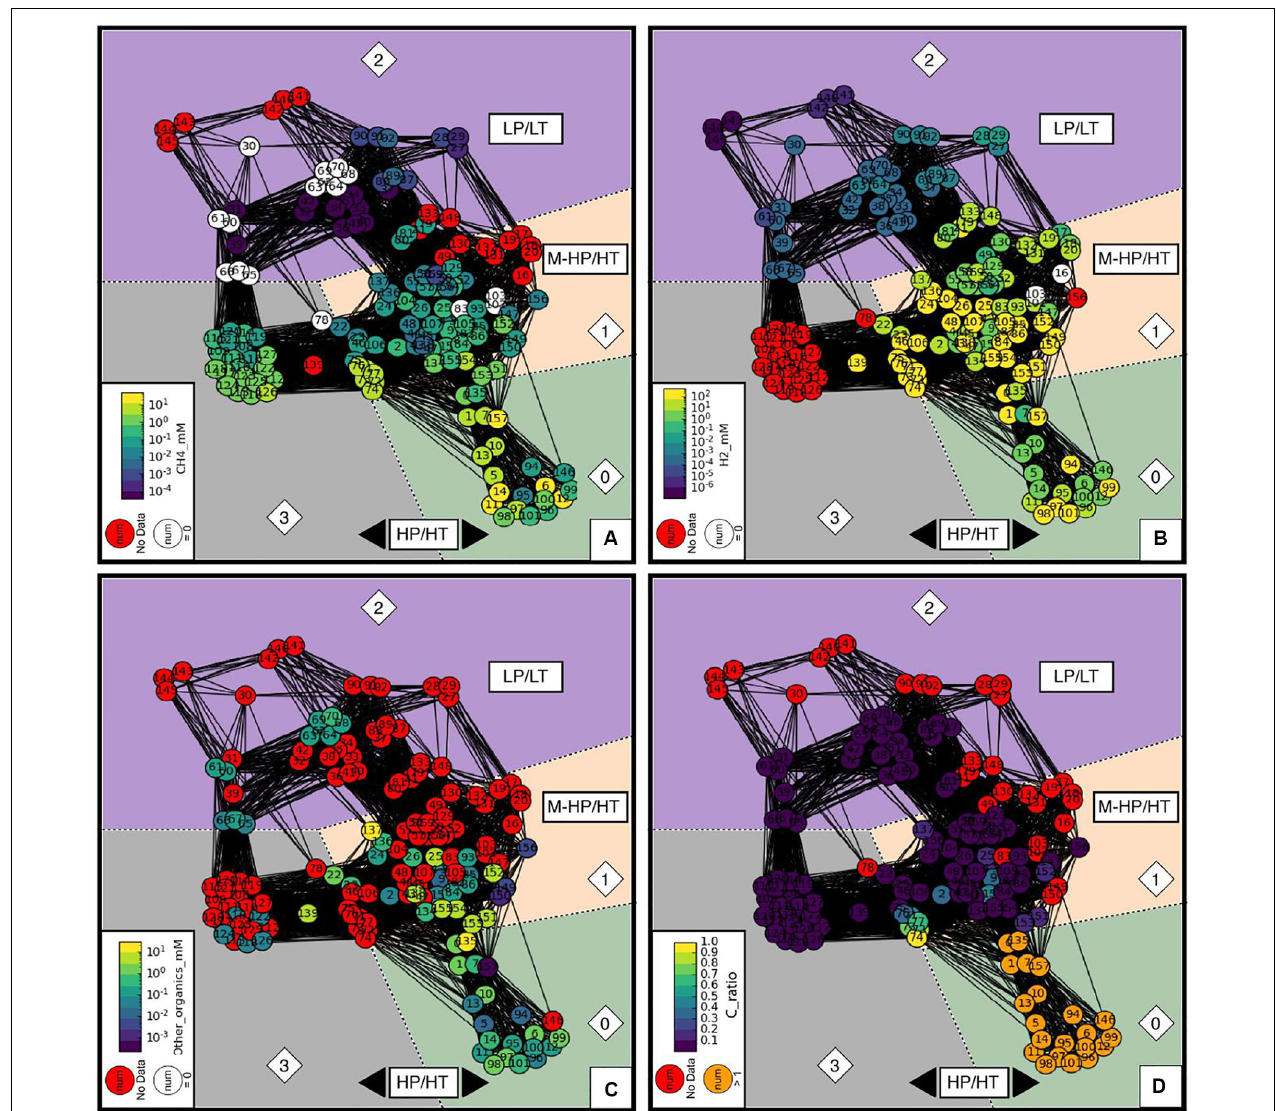
FIGURE 7 | Networks of concentrations of: (A) CH 4 , (B) H 2 , and (C) other organic species. The heatmap color from cold to warm corresponds to low to high concentrations. Red nodes refer to experiments that did not report relevant concentrations. Experiments labeled in white have concentrations below detection limits, which are set to 0 in the database. (D) C_ratio - total final carbon divided by total initial carbon. Theoretically, C_ratio should be between 0 and 1. Dark purple nodes are experiments that did not include or report initial carbon concentrations (set to 0 by convention). Red nodes refer again to final carbon concentrations not reported in the original literature. The orange nodes, mainly in community 0, are experiments reports more final carbon than initial carbon, i.e., C_ratio higher than 1. This suggests that those experiments might have undocumented contamination